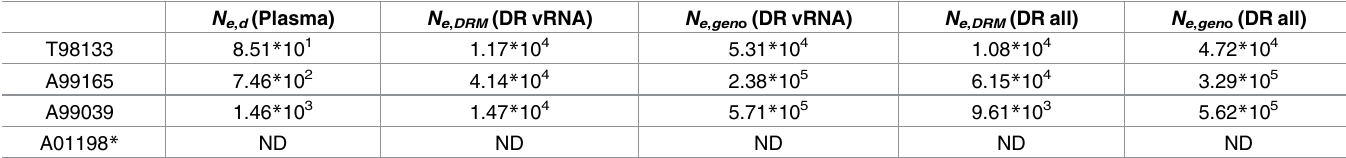
Table 2. Estimatesof N e taken after the spread of RT-SHIV drug resistance to monotherapy using three different estimation methods (see Materi- als and Methods). N e , d (Plasma) N e , DRM (DR vRNA) N e , gen o (DR vRNA) N e , DRM (DR all) N e , gen o (DR